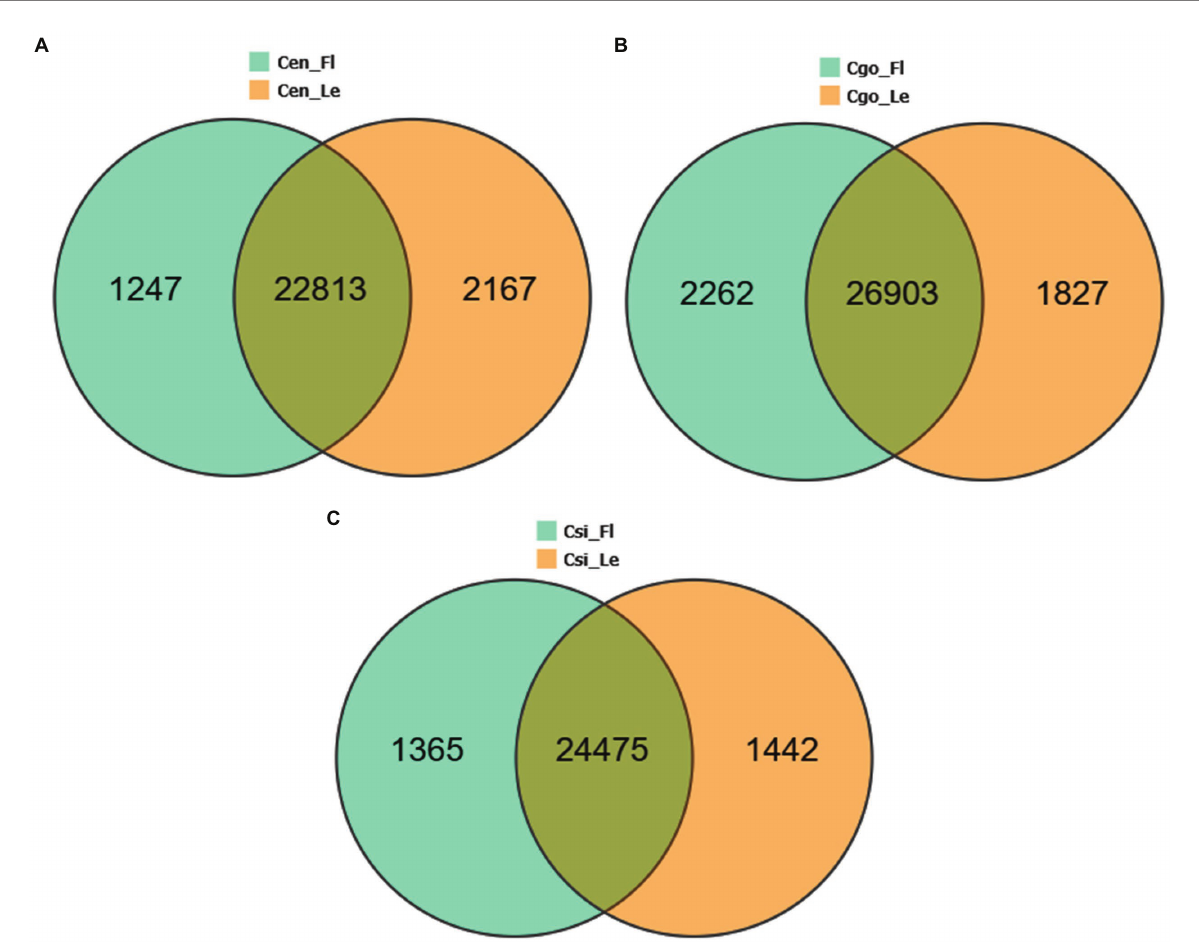
FIGURE 2 Individual species tissue-specific and common DEGs among the leaf-less control and leaf samples of C. ensifolium (A) , C. goeringii (B) , and C. sinense (C)